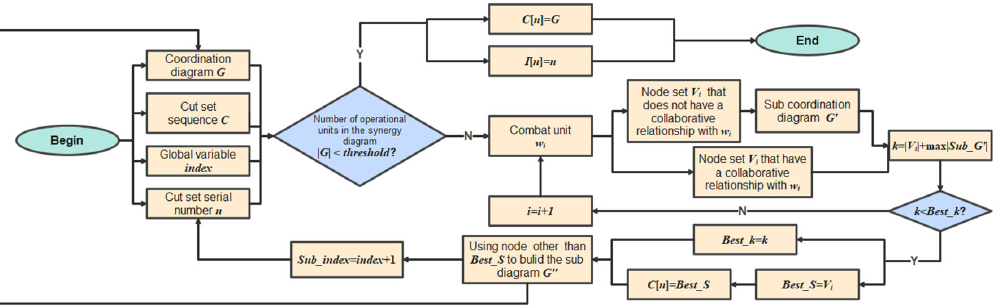
Figure 1. Cooperative diagram tree decomposition algorithm.